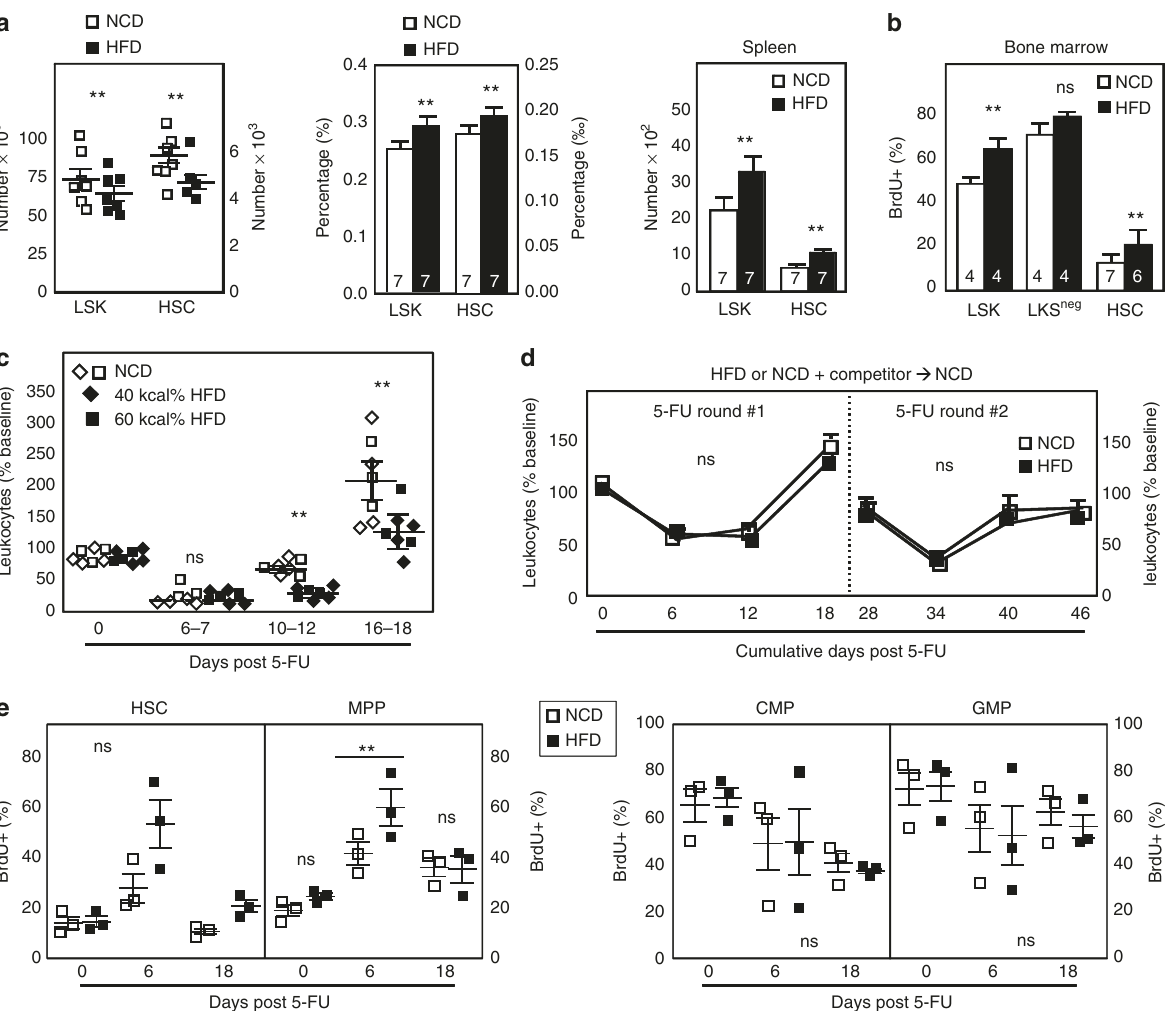
Fig. 1 Obesity compromises hematopoietic potential. a Number and percentage of multipotent BM-LSK (lineage − Sca-1 + c-kit + ) and HSC (CD150 + CD48 − LSK) in mice fed 40 kcal% high-fat diet (HFD) or nutrient-matched low fat control diet (NCD) for 16 – 18 weeks. In spleen, HSCs were identi fi ed using the CD150 + fl k2 − LSK de fi nition as rare CD150 + CD48 − LSKs were below the limit of detection by fl ow cytometry. Data represent the mean ± SEM of animals pooled from at least three independent experiments of NCD/HFD cohorts assayed in parallel for a total of n = 7 mice/group. b For analysis of BrdU incorporation, mice were injected twice daily with BrdU 48 h prior to killing. Following surface staining, cells were subsequently permeabilized for intracellular BrdU staining. Data are pooled from three independent experiments in which NCD/HFD mice were examined side-by-side with the total number of mice inset in the graph. c Mice fed the indicated high-fat diet for 16 weeks were exposed to the chemotherapy drug 5- fl uorouracil (5-FU) and peripheral blood leukocyte rebound examined. Each diet (40 kcal%, diamond; and 60 kcal%, square) was examined separately and the data pooled from a total of two independent experiments of 3 – 4 mice/group). d BM from B6 mice (CD45.2) fed either 40 kcal% high-fat diet or control diet for 16 – 18 weeks was separately mixed with competitor BM (CD45.1) and co-transferred to CD45.1/2 recipients. Following 16 weeks engraftment, a point at